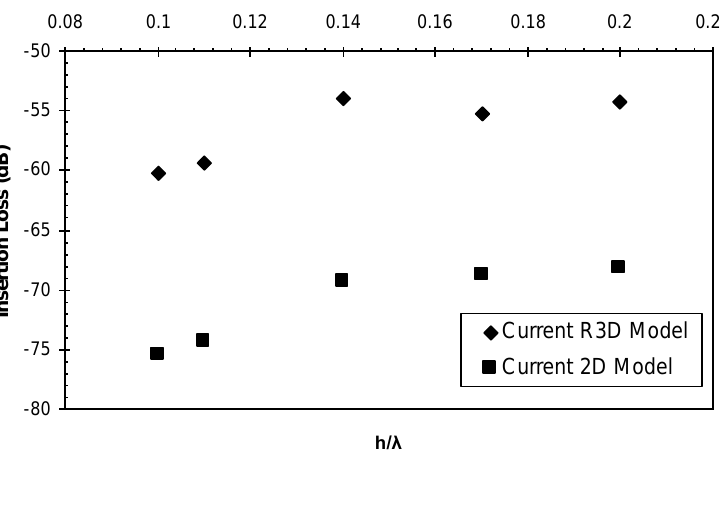
Figure 13. Comparison of insertion loss values between the R3D model and the 2D